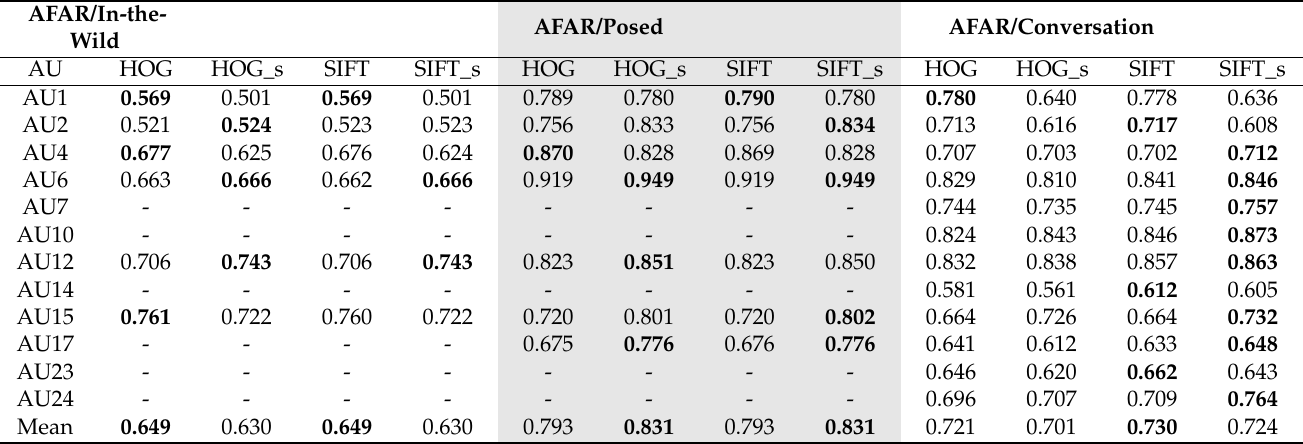
Table 3. Average AUC scores for each AU with all options activated in AFARtoolbox: HOG = histograms of oriented gradient. SIFT = scale-invariant feature transform. The letter “s” denotes the analysis of static images. Bold font denotes the highest AUC values. AFAR/In-the-